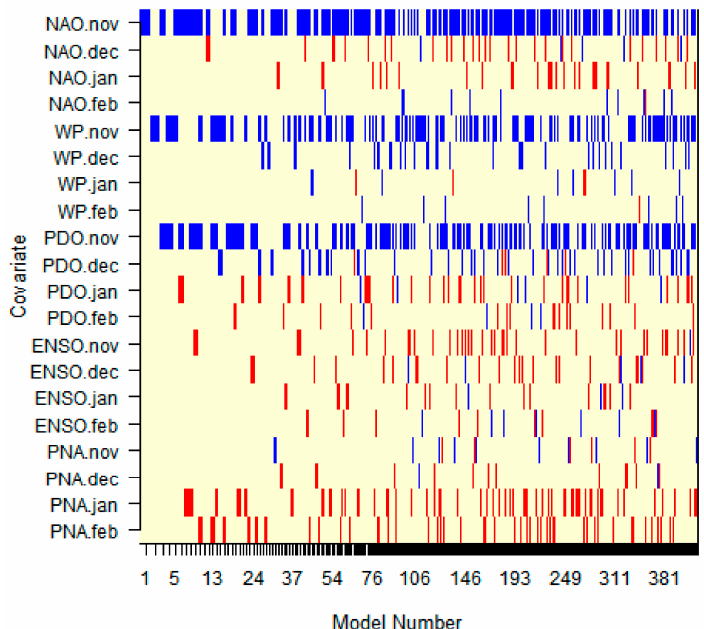
Figure 8. Model covariates vs. model number. The BIC was used for model selection. If a covariate is included in the model, it is indicated by a red (positive parameter) or blue (negative parameter) bar. The bar height is constant, and the bar width is determined by the posterior probability of the model. The probabilities decrease with increasing model number.